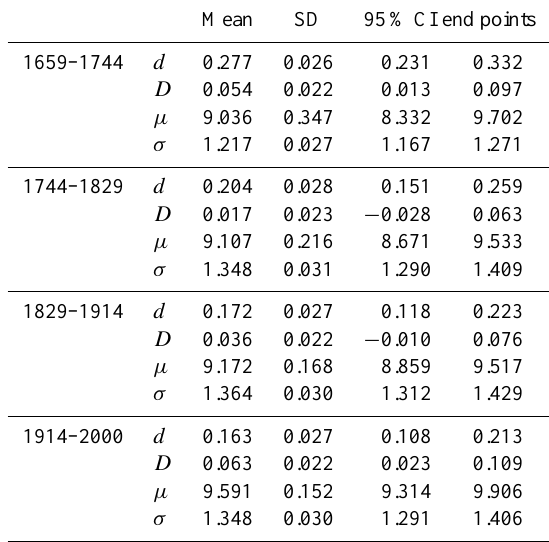
Table 8. Posterior summary statistics for four blocks of CET index for the long-memory parameter d , seasonal long-memory parame- ter D , mean µ , and noise variance σ